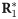
Low-dimensional amplified dynamics in random networks with unit-rank structure.A. Dynamical regimes as a function of the structure vector correlation ρ = u ⋅ v and the scaling parameter of the connectivity matrix, Δ. Grey shaded areas correspond to parameter regions where the network activity is monotonic for all inputs; blue shaded areas indicate parameter regions where the network activity is amplified for specific inputs; for parameter values in the white area, activity is unstable. Samples of dynamics are shown in the bottom panels, for parameter values indicated by the colored dot in the phase diagram: Δ = 4 and ρ = 0. Dashed colored traces correspond to the parameter regions explored in panels B. and C., defined by the equation λ = Δρ. B. Maximum amplification of the system, quantified by σ1(Pt*), the first singular value of the propagator, as a function of the scaling parameter Δ. Here we fix the eigenvalue of the connectivity matrix λ = Δρ associated with the eigenvector u, and vary Δ. Colored traces correspond to different choices of the eigenvalue of the connectivity λ. C. Correlation between the optimally amplified input direction R1* and the structure vector v as a function of the parameter Δ. Increasing the non-normal parameter Δ aligns the optimally amplified input with the structure vector v. In B. and C. mean and standard deviation over 50 realizations of the connectivity matrix are shown for each trace. The elements of the structure vectors are drawn from a Gaussian distribution, so that they have on average unit norm and correlation ρ (see Methods). D. Low-dimensional dynamics in the case of two stored patterns. Input v(1) (resp. v(2)) elicits a two-dimensional trajectory which brings the activity along the other structure vector u(1) (resp. u(2)), mapping stimulus v(1) (resp. v(2)) into its transient readout u(1) (resp. u(2)). Blue and red colors correspond to the two stored patterns. E. Firing rates of 10 individual units. F. Temporal evolution of the activity norm. G. Projection of the network response evoked by the input along v(1) (resp. v(2)) on the corresponding readout u(1) (resp. u(2)). The case of unit rank connectivity (one stored pattern) reduces to the first row of panels D. −G. (where the activity on u(2) is equivalent to the activity on a readout orthogonal to u(1)). N = 3000 in simulations.